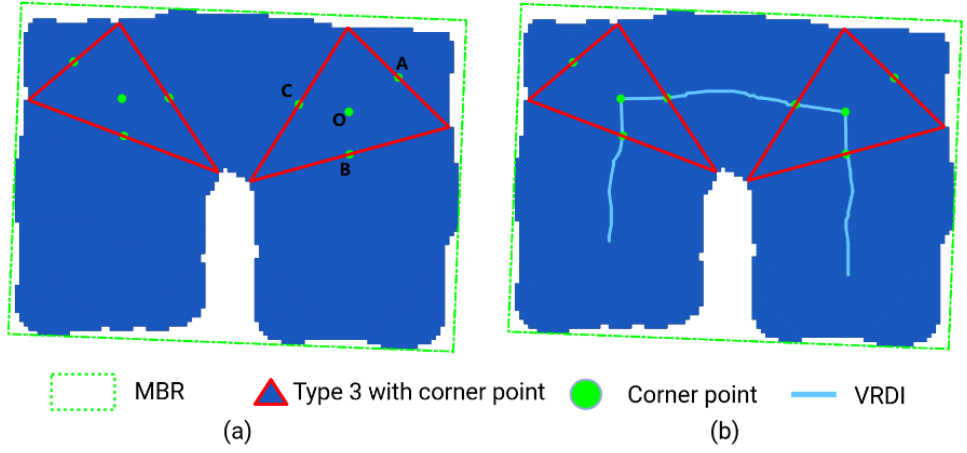
Figure 12. Type three with corner points. ( a ) C-shaped building with corner point; ( b ) Result of VRDI method for corner point.